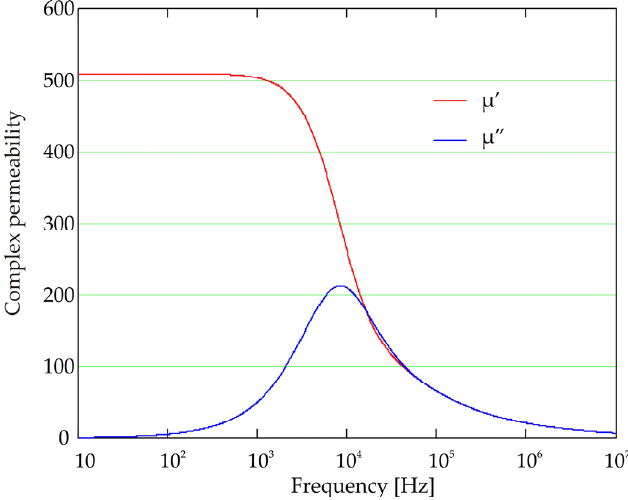
Figure 7. Complex permeability of laminated core as a function of frequency.